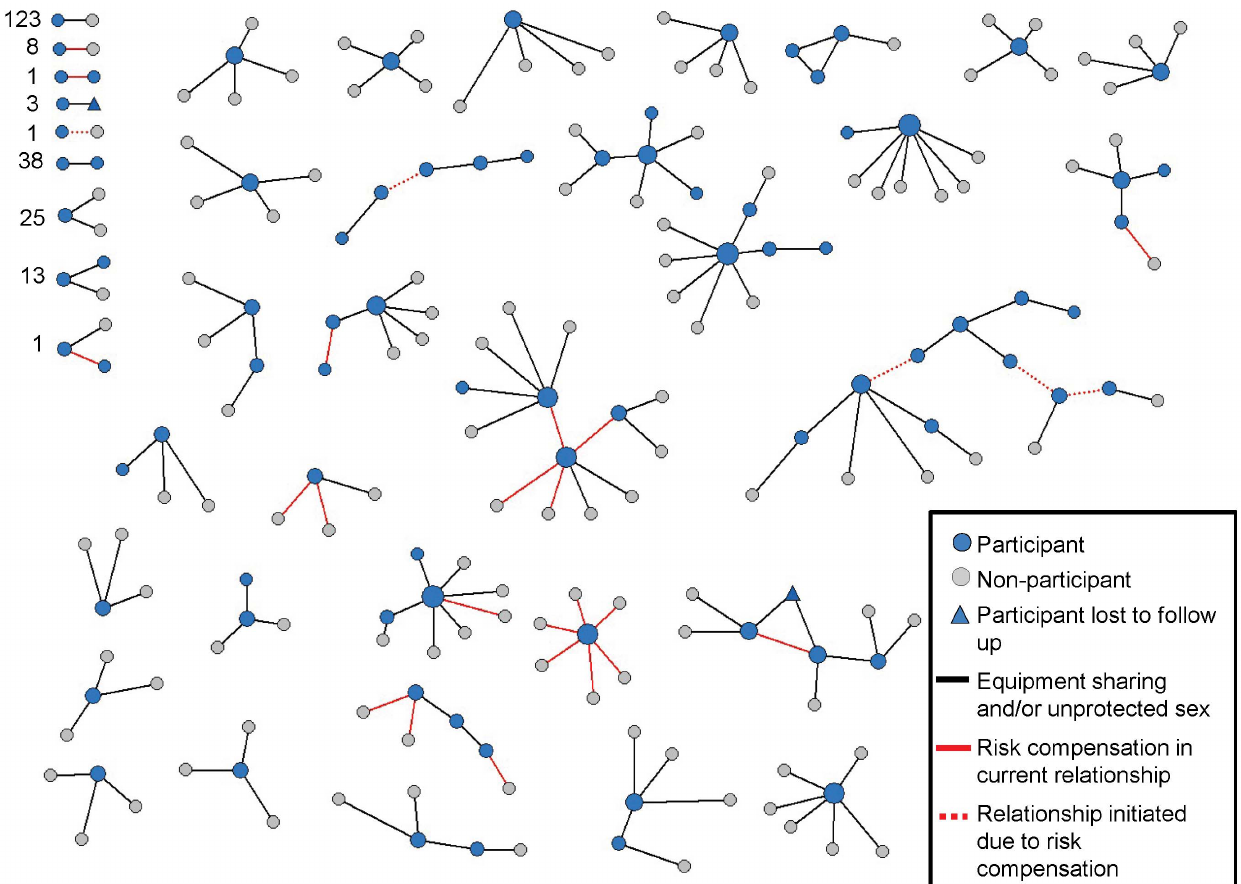
Figure 4. Risk compensation within a risk network of rural drug users. Nodes are sized by degree centrality (i.e. number of partners). The figure does not include the 95 participants who did not someone with whom they shared equipment or had unprotected sex.